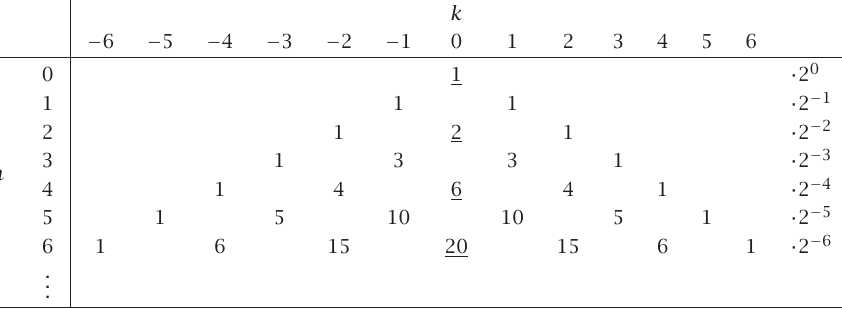
Table 2.1 . The first values of Q 0 (n,k) . The representation is chosen in a way that the well-known Pascal triangle gets visible. The number in row n and column k represents the number of ways which lead to point k after the n th step. Multiplication by the factor 2 − n yields Q 0 (n,k) . The last column contains these factors. In every row n the number of ways which lead back to the origin after n steps is underlined. Multiplication by 2 − n yields the return probability Q 0 (n, 0 ) .